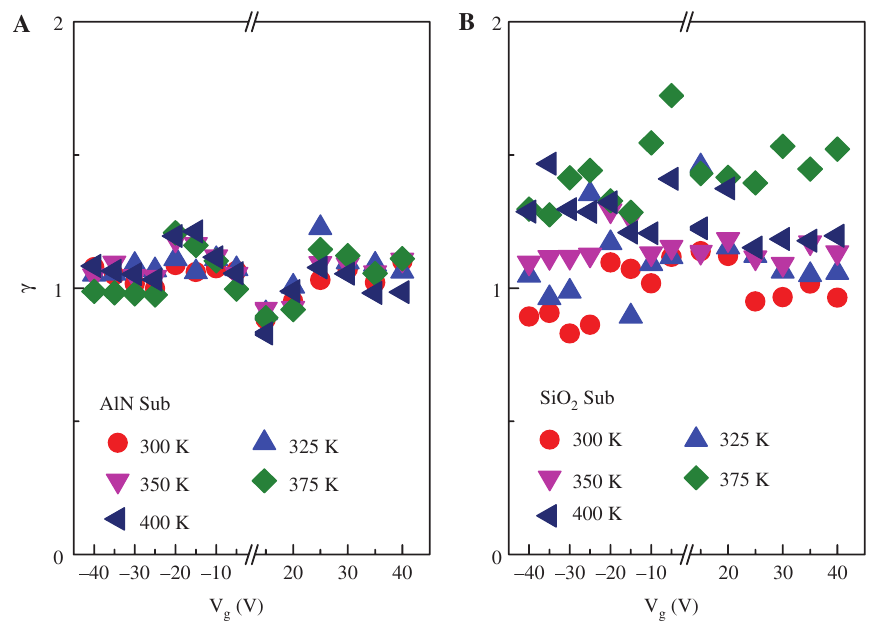
Figure 5: LFN characteristics of BP FETs as functions of frequency and temperature. The value of γ extracted from the slope of fitting lines of LFN for BP FETs on (A) AlN/SiO